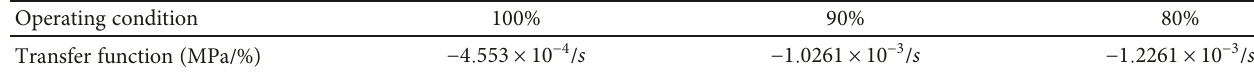
Table 1: Mathematical model of the controlled object.